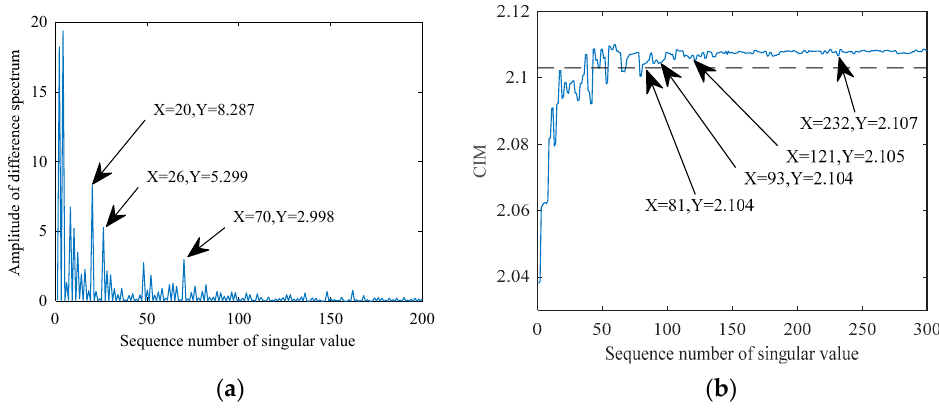
Figure 15. Difference spectrum and CIM. ( a ) Difference spectrum of the SVD. ( b ) CIM between the SCs and original signal.